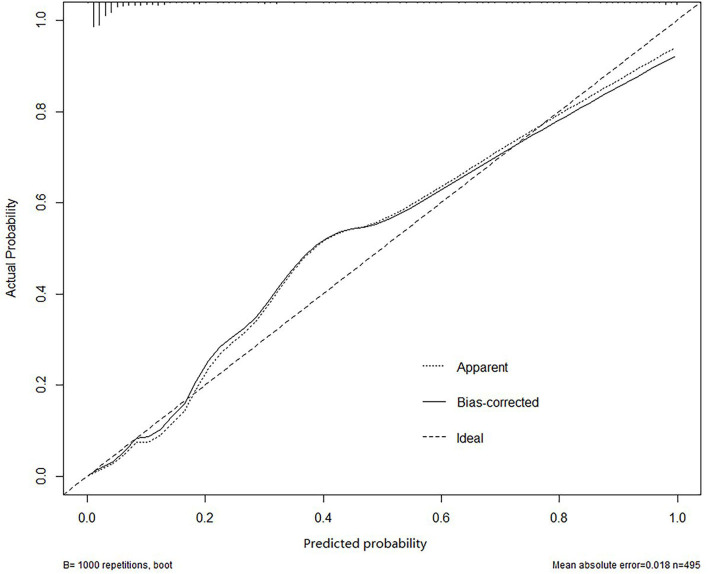
The result of bootstrap validation.